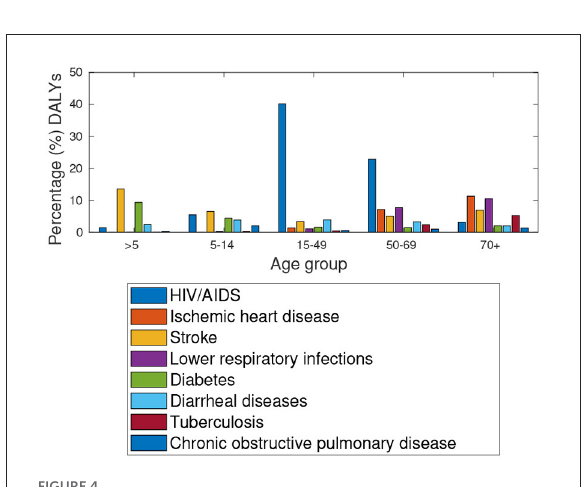
FIGURE4 Botswana: Percentage (%) of total DALYs, Comorbidities in